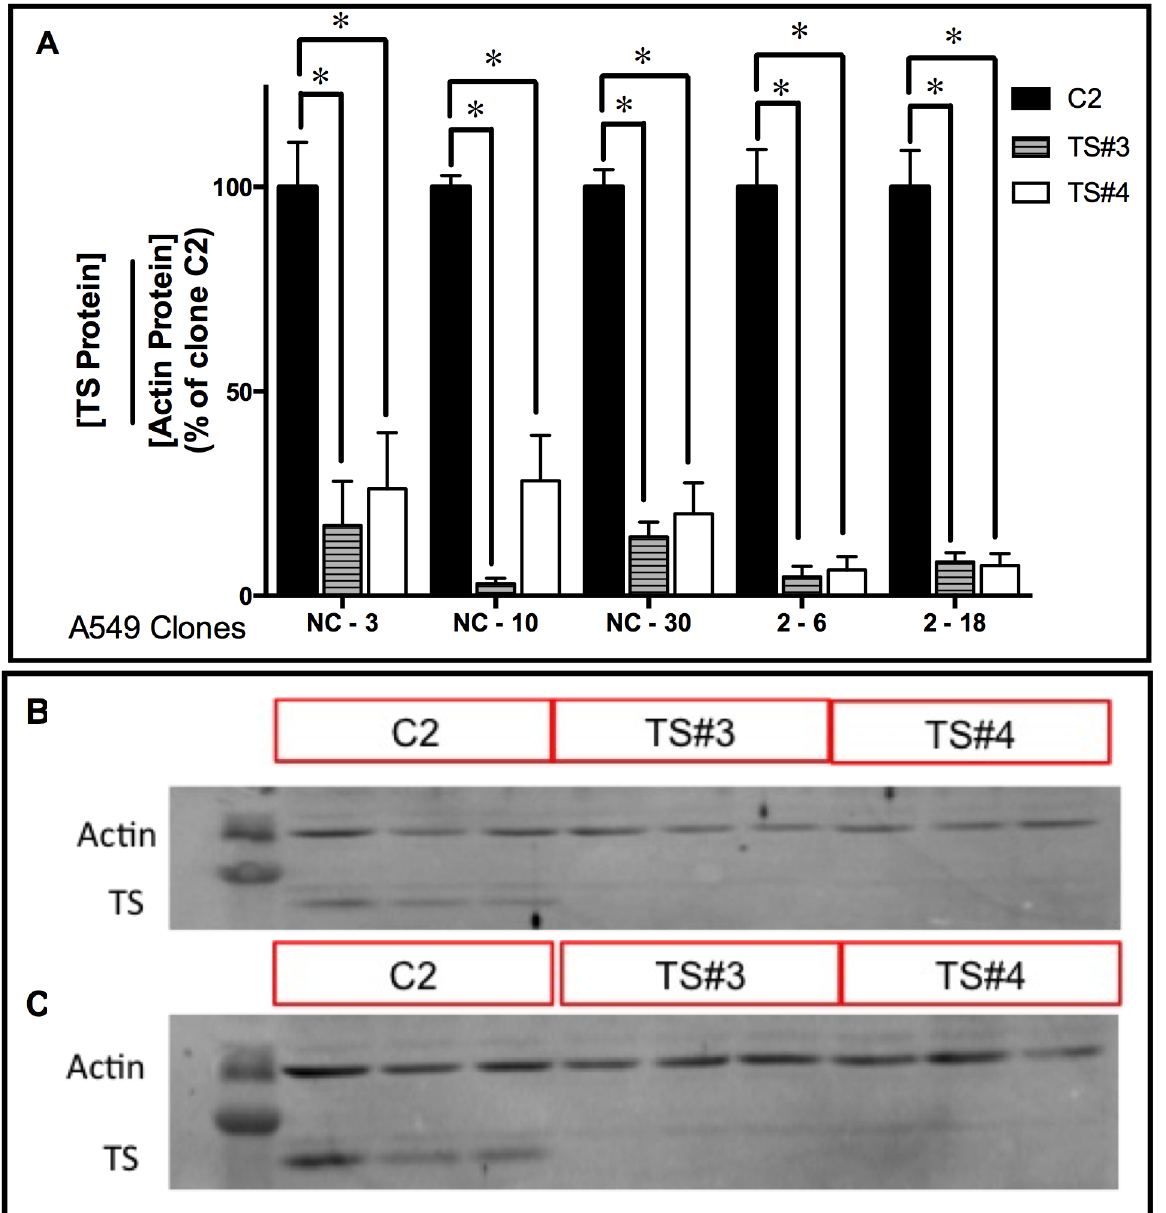
Fig 6. TS siRNA downregulation in A549 clonal populations. A549 clonal cell populations (NC-3, NC-10, and NC-30, each with stably-incorporated control, non-targeting scrambled shRNA; and 2 – 6 and 2 – 18, each with stably-incorporated anti-IDO shRNA) were seeded and grown overnight. Thymidylate synthase (TS) siRNA numbers 3 or 4, or scrambled, non-targeting control siRNA, were transiently transfected into each clonal population. Cells were lysed and protein was harvested 96 h later. TS and actin protein levels were determined by immunoblot. Results were quantified for each clone separately. A : TS protein quantification for each clonal population. Each bar represents the mean of 3 values ( n = 3) ± SEM. * Significant difference from the same cells transfected with scrambled control, non-targeting siRNA, Student's t -test, p < 0.05. B : Representative immunoblots of TS and actin protein in clone NC-3 after transfection of TS siRNA (siRNA numbers 3 and 4) or scrambled, non-targeting control siRNA (C2). C : Representative immunoblots of TS and actin protein in clone 2 – 18 after transfection of TS siRNA.